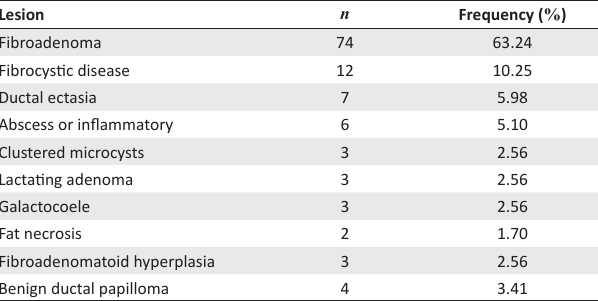
FIGURE 1: Palpable right breast lump in an 18-year-old woman noticed 6 months previously. Ultrasound showed an oval-shaped homogenous hypoechoic mass with well-defined margins. Posterior acoustic enhancement and edge shadowing are seen. Histology confirmed the diagnosis of a fibroadenoma. TABLE 3: Types of benign breast